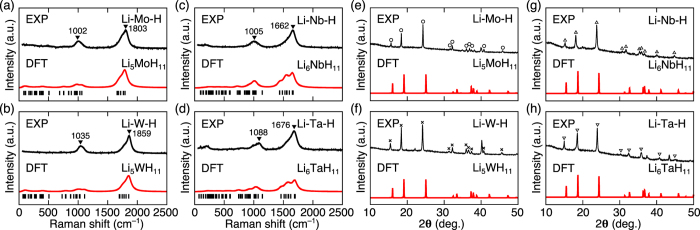
Raman spectra and X-ray diffraction (XRD) profiles.(a–d) Raman spectra. Experimental spectra (black lines) and DFT spectra (red lines) for Li5MoH11 (a), Li5WH11 (b), Li6NbH11 (c) and Li6TaH11 (d). All of the zone-centre optical phonon frequencies obtained from DFT calculations are represented by tick marks for reference. (e–h) XRD profiles. Experimental profiles (black lines) and simulated profiles from DFT structures (red lines) for Li5MoH11 (e), Li5WH11 (f), Li6NbH11 (g) and Li6TaH11 (h). The open circles, cross marks, open triangles and open upside–down triangles indicate the diffraction peaks correspond to Li5MoH11, Li5WH11, Li6NbH11 and Li6TaH11, respectively.